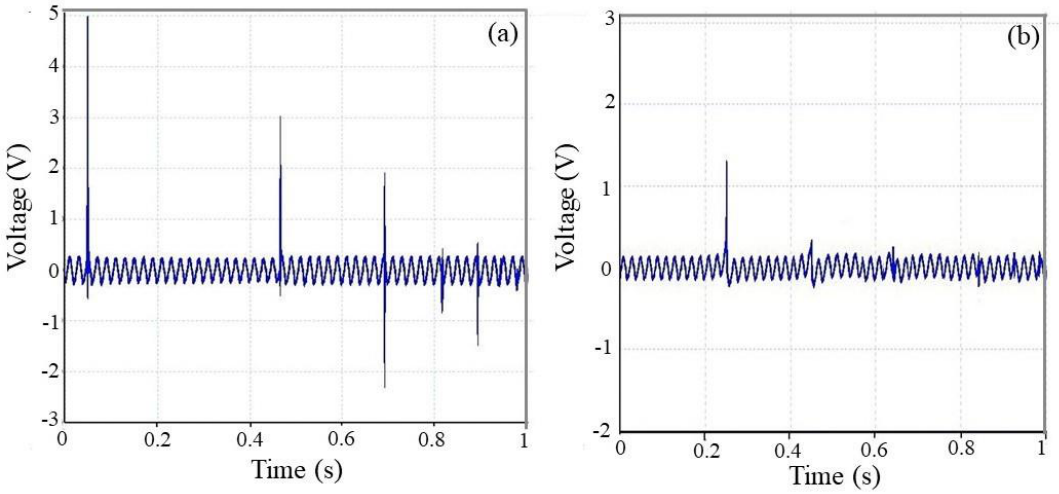
Figure 3. Piezoelectric response of nanogenerators, excited by the drop weight impact test on the electrospun web of in 250 μm thickness: ( a ) PVDF/LiCl (0.00133 wt %) and ( b ) pure PVDF.